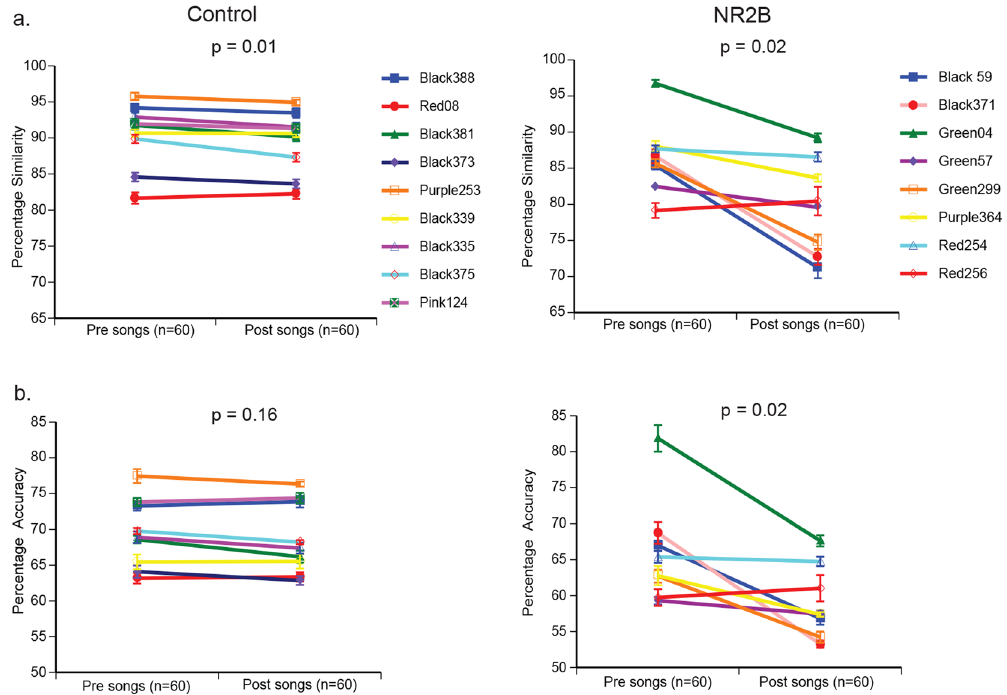
Figure 7. Song similarity changes after overexpression of human NR2B in LMAN. ( a ) Percentage similarity before and after injections in control or NR2B groups. ( b ) Percentage accuracy. Each line is one animal presurgery and postsurgery, mean ± SE, with p values determined using paired Wilcoxon signed-rank